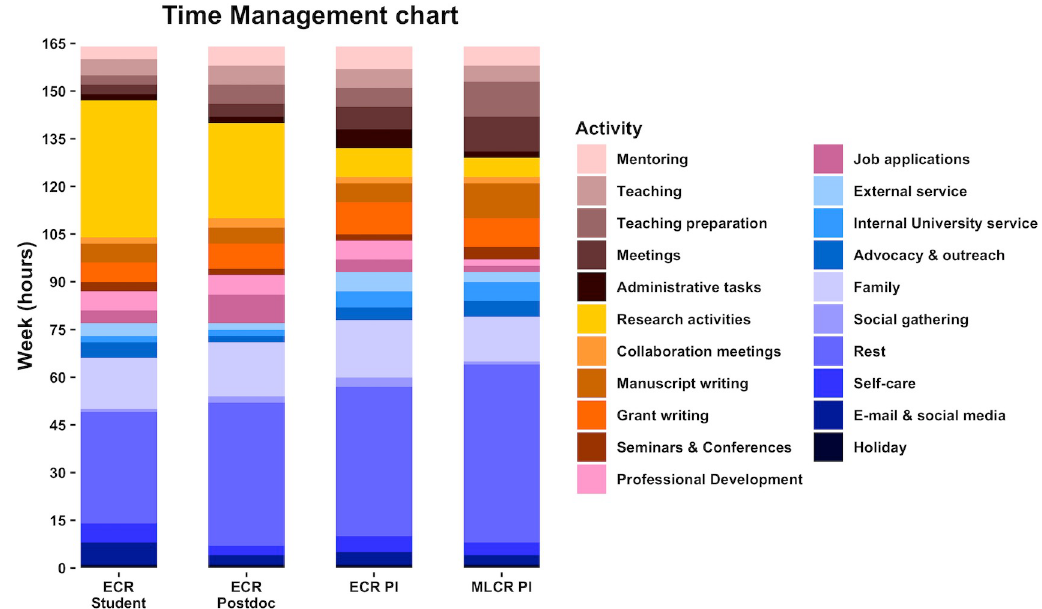
Fig 1. Time management charts to help monitor workload and prioritize activities. Dynamic, prospective, or retrospective weekly or monthly time management assessment charts can help researchers with improving their work–life balance by determining exactly how they spend their time. There are 164 hours in a week. Example hour allocation is shown here for academics across career stages [50]. Hours allocated will vary depending on the researcher’s disciplines (for instance, humanities versus life sciences or engineering) and circumstances such as end or beginning of semester, when approaching a deadline, or when a committee is busiest. Teaching responsibilities include course instruction and administration, including grading and evaluation. Family time includes interacting, dining, and performing housekeeping chores with family members. Research activities include performing research and literature review time. External service may include manuscript or grant reviewing and editorial tasks. Meetings may include lab/group meetings, departmental faculty meetings, or other council meetings. Self- care activities may include attending to one’s hobbies. Internal service includes department and university service. Weekends and public holidays are included in the weeks. Other tasks not included in this chart may be professional development, writing letters of recommendation, advising undergraduate students, faculty and student hiring/recruitment, marketing/public relations, fundraising, phone calls, reception/dinner, commute/travel, scheduling/planning, and reporting. ECR, early career researcher; MLCR, mid- to later career researcher; PI, principal investigator. Figure created using ggplot library in R